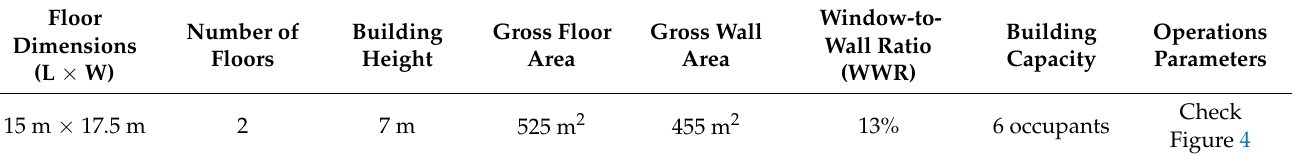
Figure 3. The selected archetypical baseline building model and its orientation. Table 3. The selected baseline building parameters.